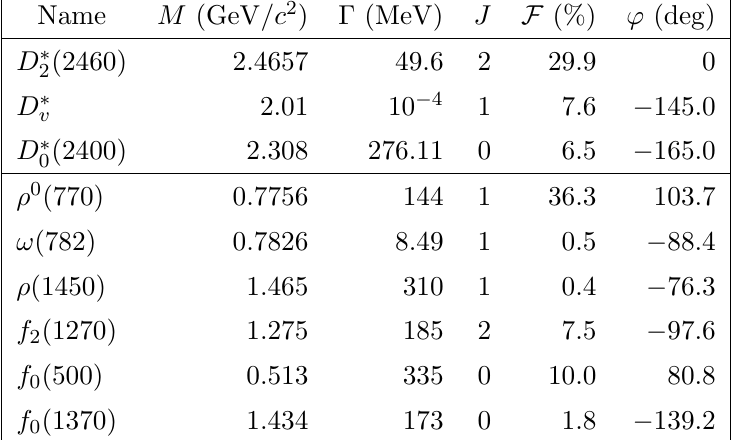
D(cid:25) + (cid:25) (cid:0) , D K 0 (cid:25) + (cid:25) (cid:0) process. Black solid arrows S ! ! D and B D ! !